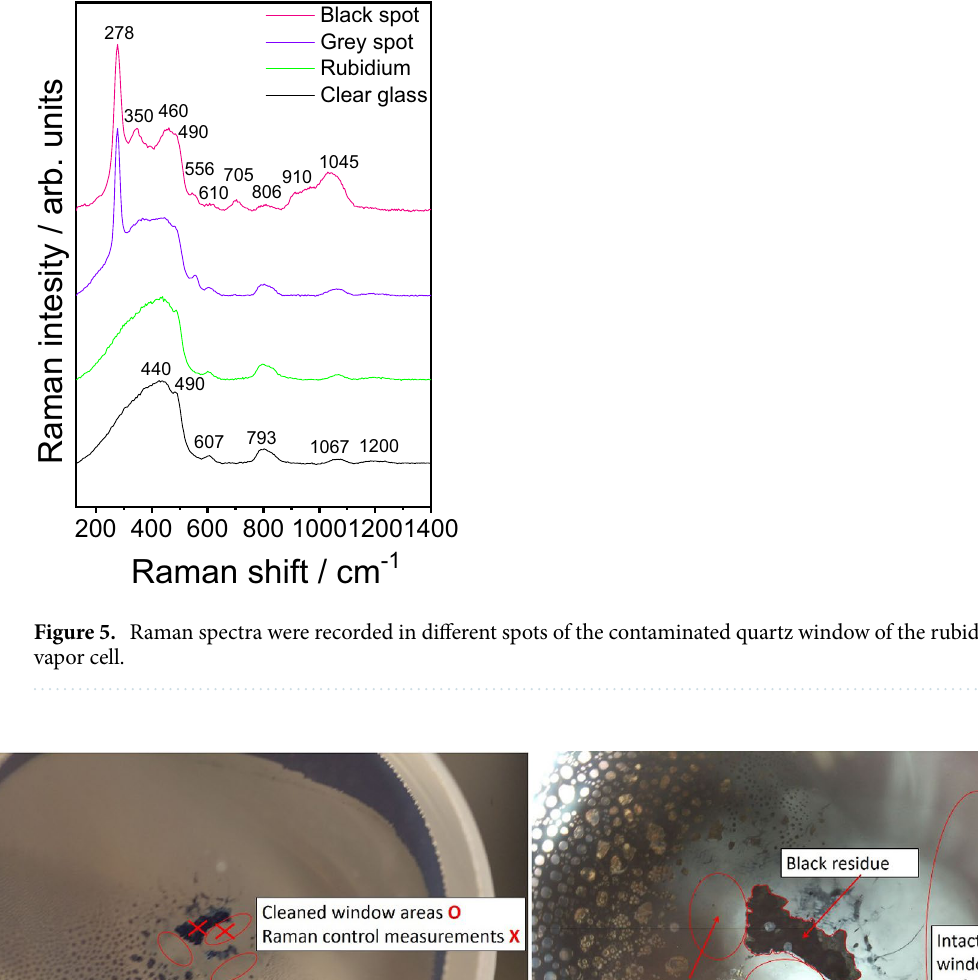
similar to the previous one, indicating that the metal covering the quartz window in these places does not incor- porate into the glass matrix. On the other hand, the Raman spectrum of the contamination is remarkably different (grey and black spots in Fig. 6). A strong and narrow peak dominates the curves of both the grey and black regions at 278 cm −1 . Addi- tional new bands of smaller intensity can also be detected at 350, 460, 556, 910 and 1045 cm −1 . From these new peaks, the 350, 910 and 1045 cm −1 ones are present in the spectrum of the black spot only. The characteristic Raman features of the fused silica can also be observed, serving as a background for the new peaks. However, the shape of some bands differs from that observed in the clean spot spectrum, indicating the glass’s structural transformation in the contamination area. The contaminant was formed under high-energy pulsed laser radiation in a closed cell filled with rubidium vapor. Therefore, it can be assumed that the grey and black discolored residues consist of the material inside the cell, namely quartz and/or rubidium—moreover, the easy contamination removal by a cca. 3 kJ/cm 2 nanosecond pulsed laser indicates that it is a particulate material aggregated on the inner surface of the quartz window (and not the result of the incorporation of the metal into the glass), and the new Raman peaks arise from this structure. The effect of alkali cations on Raman spectra and the structure of SiO 2 glasses were investigated earlier 75 . The differences in the silicate networks of (M 2 O) x (SiO 2 ) 100-x glasses (M = Li, Na, K, Rb, Cs and x = 5, 10, 15, 20, 25, 30) were established and characteristic vibrational modes in the Raman spectra of alkali-silicate glasses were also